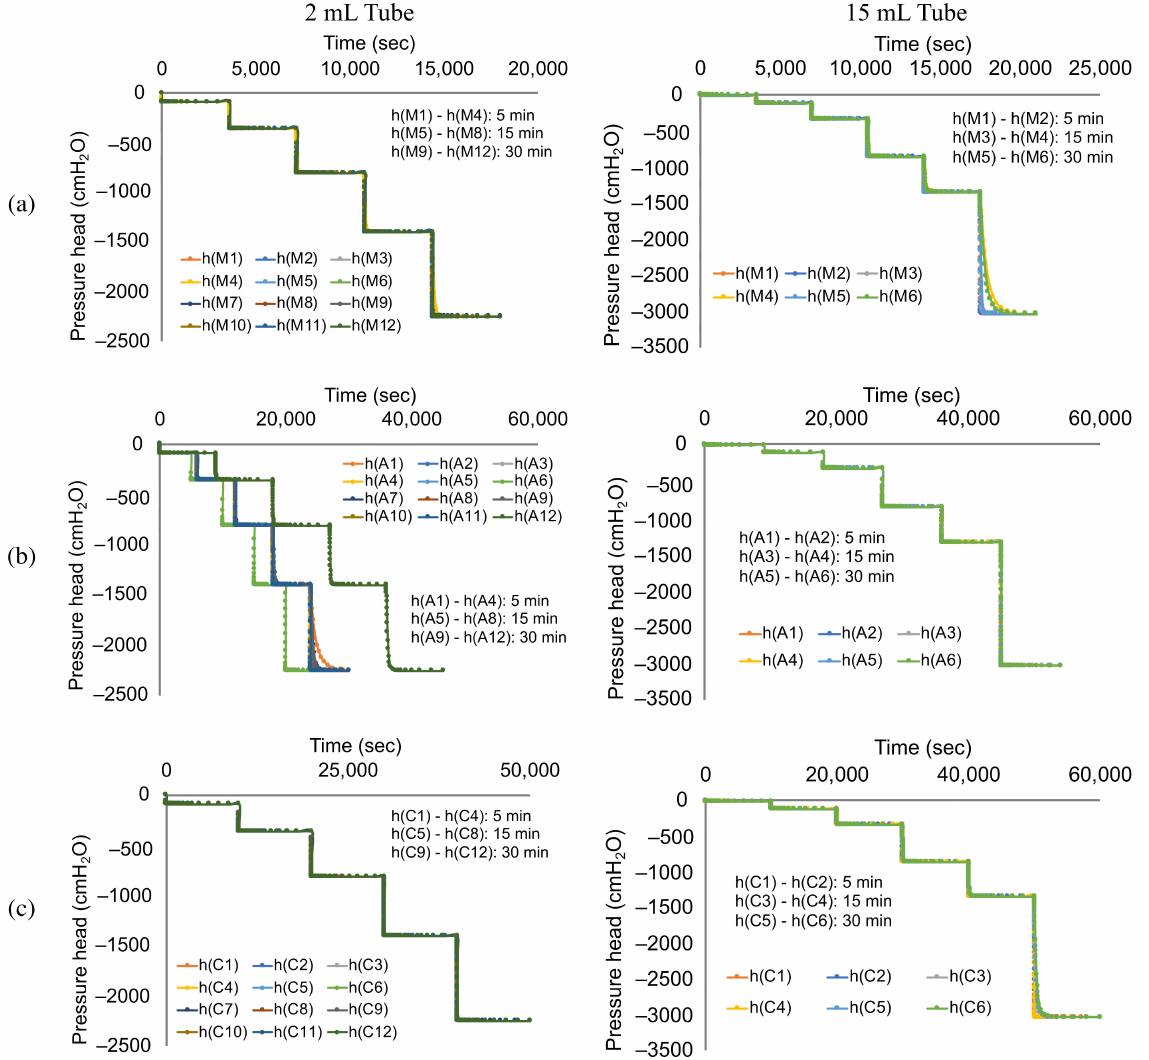
Figure 6. Optimized pressure head as extension time of 2 mL and 15 mL tubes: ( a ) Decomposed granite soil (Masa soil); ( b ) Volcanic ash soil (Andisol soil); ( c ) Paddy